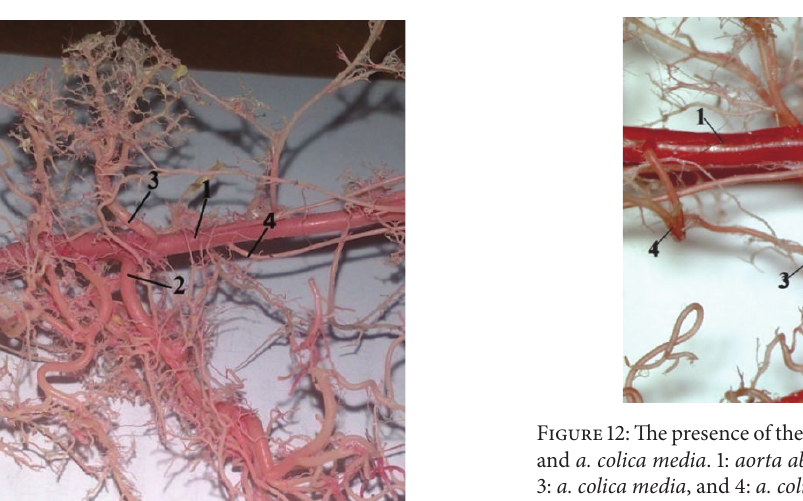
Figure 11: Photograph focusing the division of the a. mesenterica caudalis . 1: aorta abdominalis , 2: a. mesenterica caudalis , 3: a. colica sinistra , and 4: a. rectalis cranialis (casting medium PUR SP).